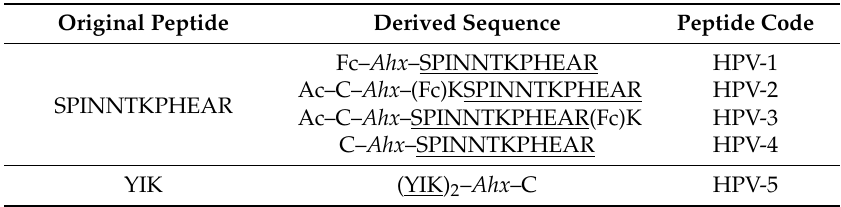
Table 1. Designed and synthesized